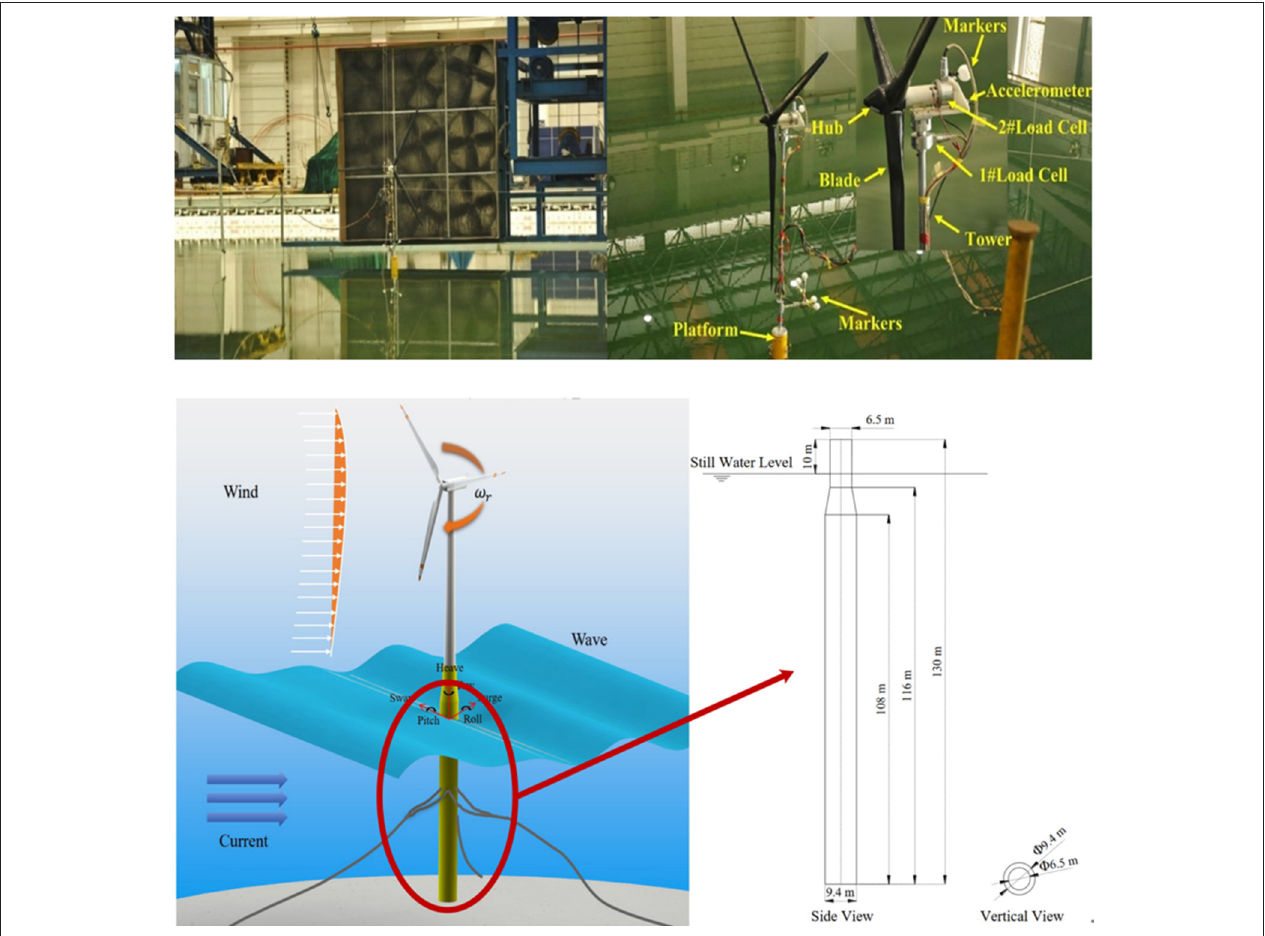
FIGURE 3 | Experimental model & sensors and main dimensions of spar-type Floater.